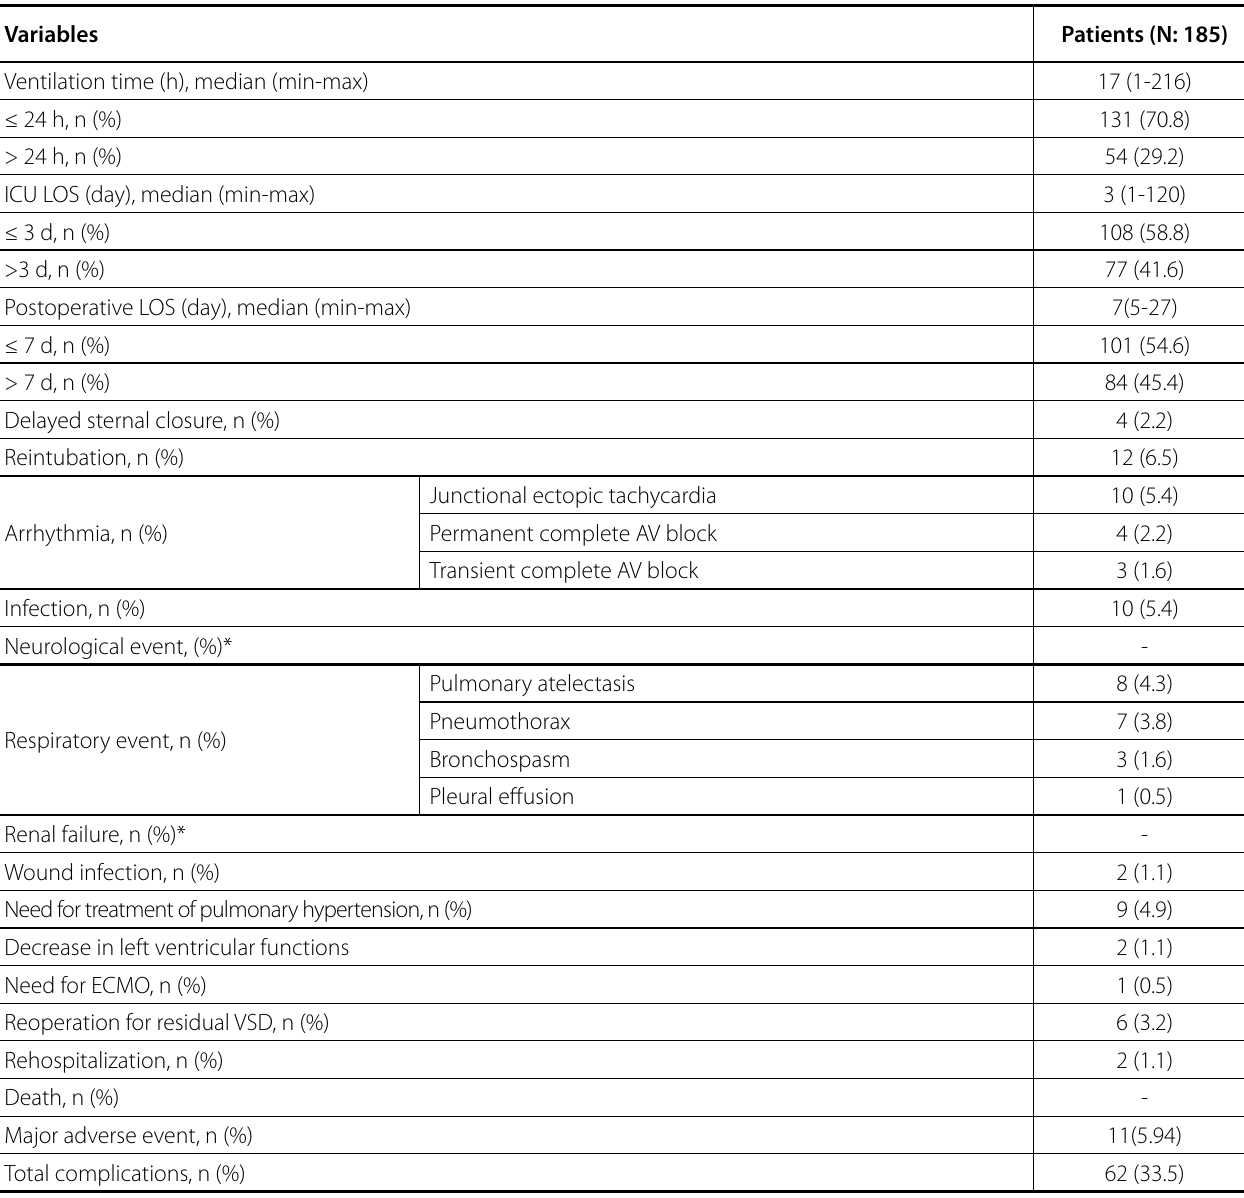
Table 2 . Postoperative